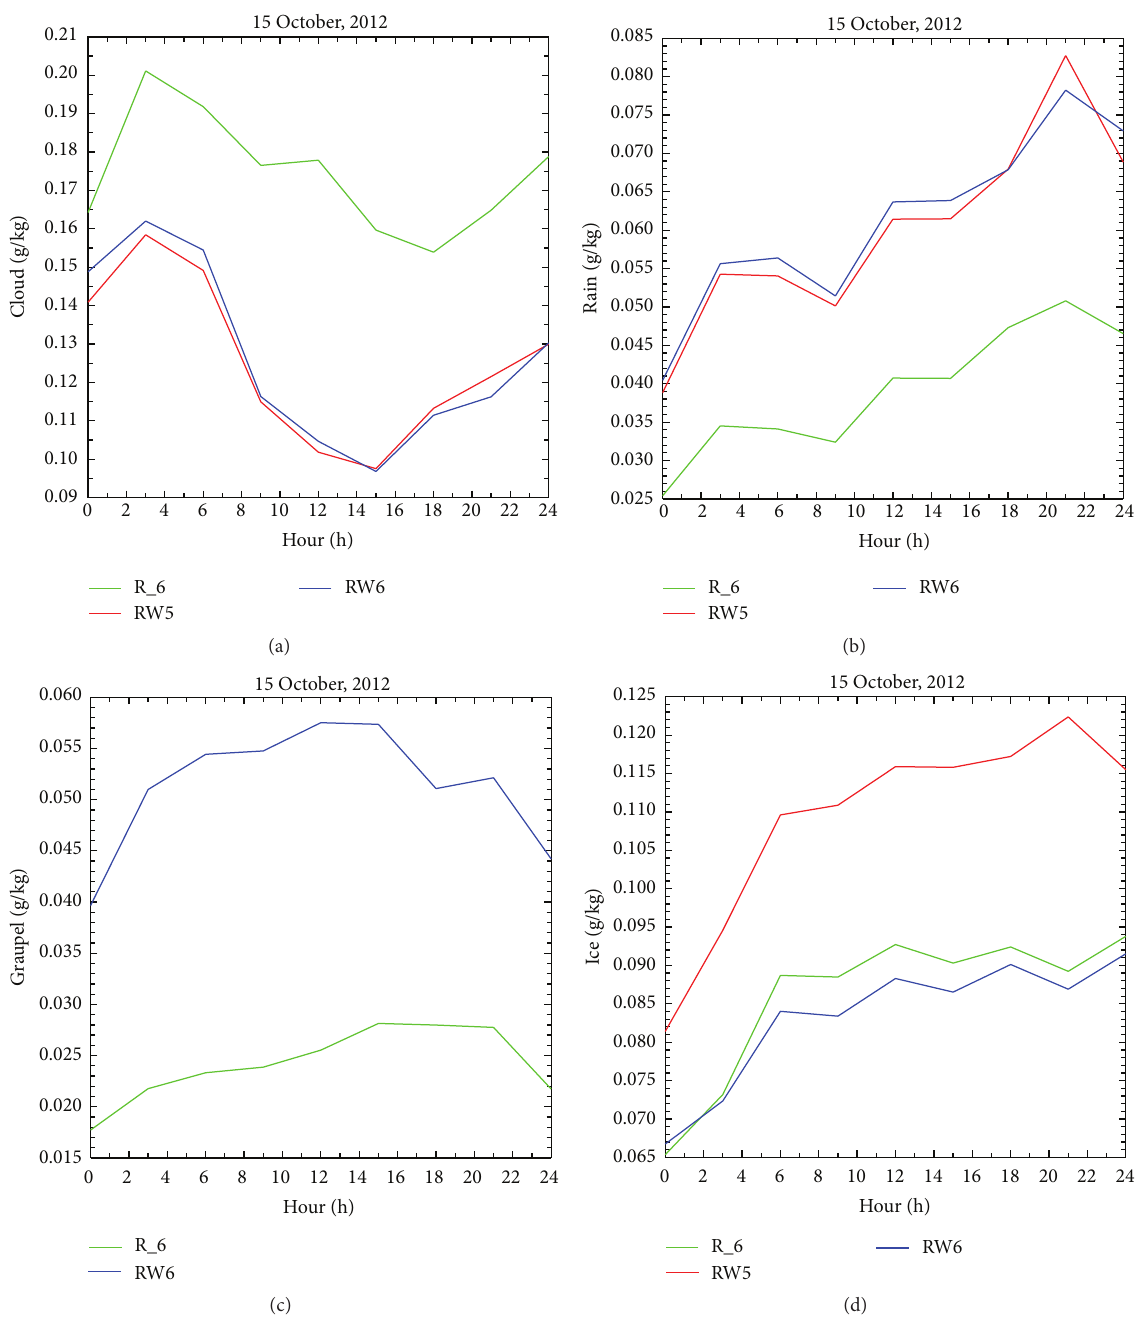
Figure 3: Domain-averaged mixing ratios (g/kg) for (a) cloud; (b) rain; (c) graupel; (d) ice. The hydrometeor ice for R 6 is the sum of the pristine ice, snow, and aggregates hydrometeors, while it is the sum of cloud ice and snow categories for RW5 and RW6. The graupel of R 6 is the sum of graupel and hail categories. R 6 is in green, RW5 in red, and RW6 in blue.